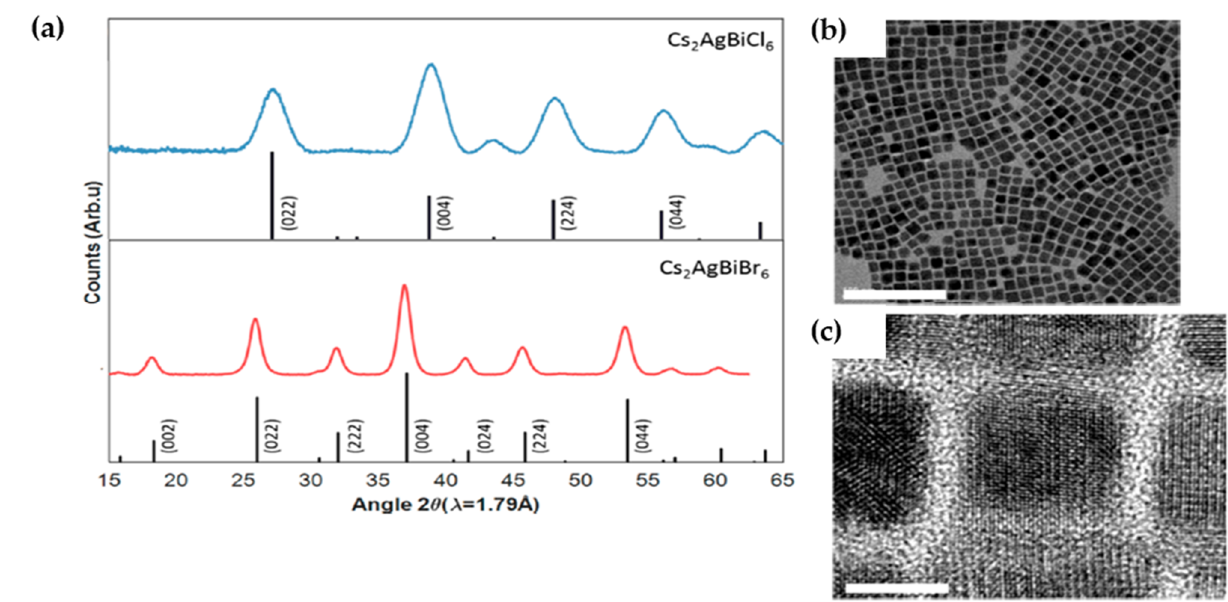
Figure 7. ( a ) XRD pattern of Cs 2 AgBiBr 6 (red) and Cs 2 AgBiCl 6 (blue) NCs in comparison with reported XRD patterns where scale bars refer to the other published XRD patterns for Cs 2 AgBiBr 6 and Cs 2 AgBiBr 6 perovskites; ( b ) low-resolution and; ( c ) high-resolution TEM images of Cs 2 AgBiBr 6 NCs showing atomic lattice fringes. Reproduced with permission from [59]. Copyright 2018, American Chemical society.